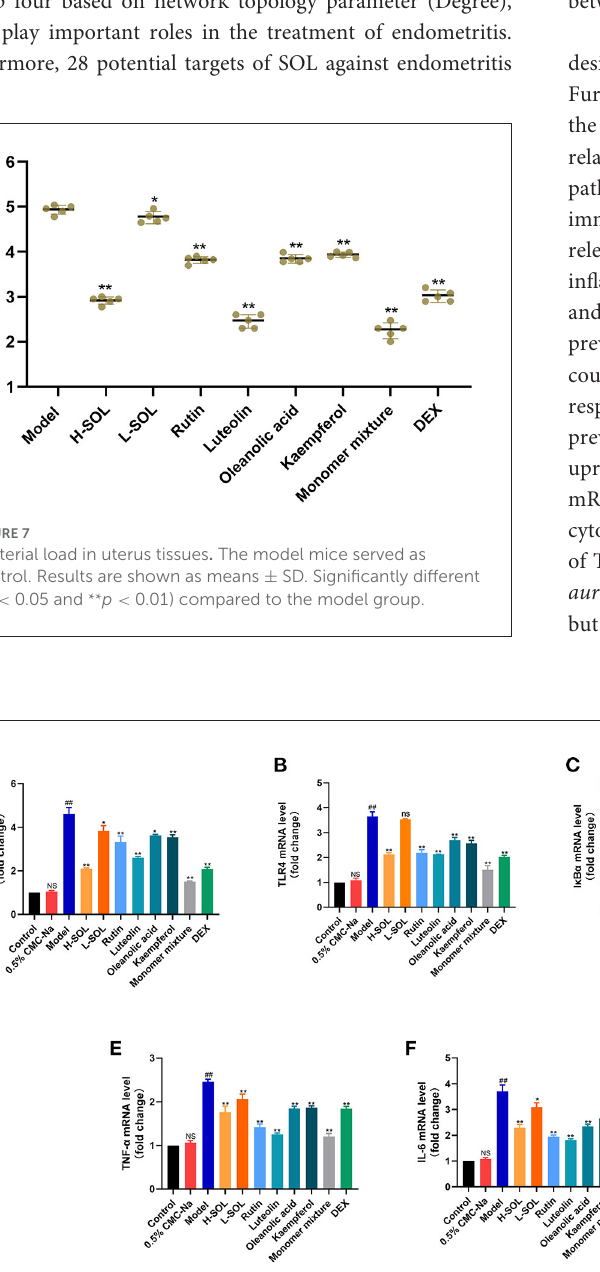
FIGURE8 Real-time PCR analysis of TLR2 (A) , TLR4 (B) , I κ B α (C) , NF- κ B (D) , TNF- α (E) , IL-6 (F) , and IL-1 β (G) transcripts in uterus sample. The relative gene expression level was normalized to the GAPDH and reported as relative to the normalized expression in the control group (fold=1). Data are expressed as the mean value ± standard deviation (SD). Statistical analysis is performed with the student’s t -test. ## p < 0.01, NS vs. control group; * p < 0.05, ** p < 0.01 and ns vs. model group; NS or ns, no significant